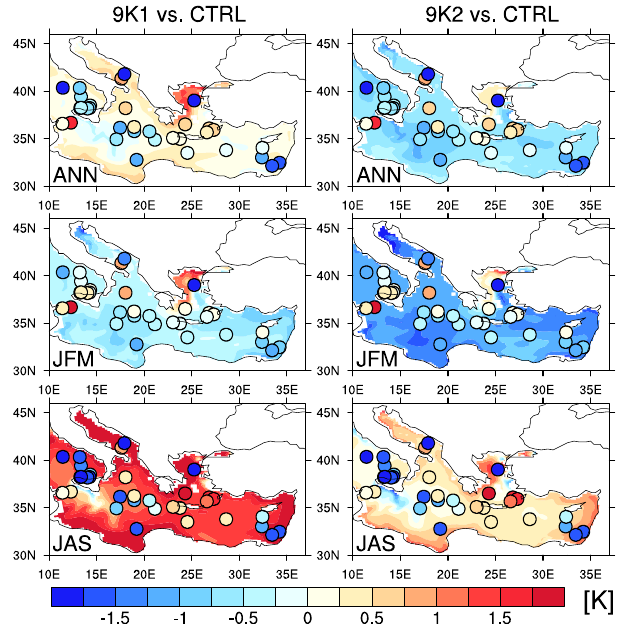
Fig. 19. Annual, winter (JFM) and summer (JAS) SST anomalies, reconstructed from proxy data (dots, Kucera et al. (2011)) vs. mod- elled one (background colour) for 9K1 vs. CTRL (left) and 9K2 vs. CTRL (right). 1st row displays annual SST anomalies, 2nd row displays winter SST anomalies, 3rd row displays summer SST